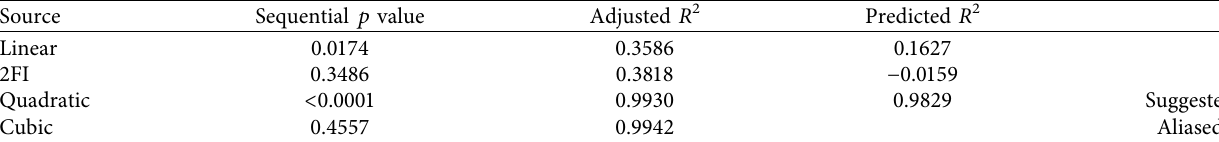
Table 7: Fit summaries.